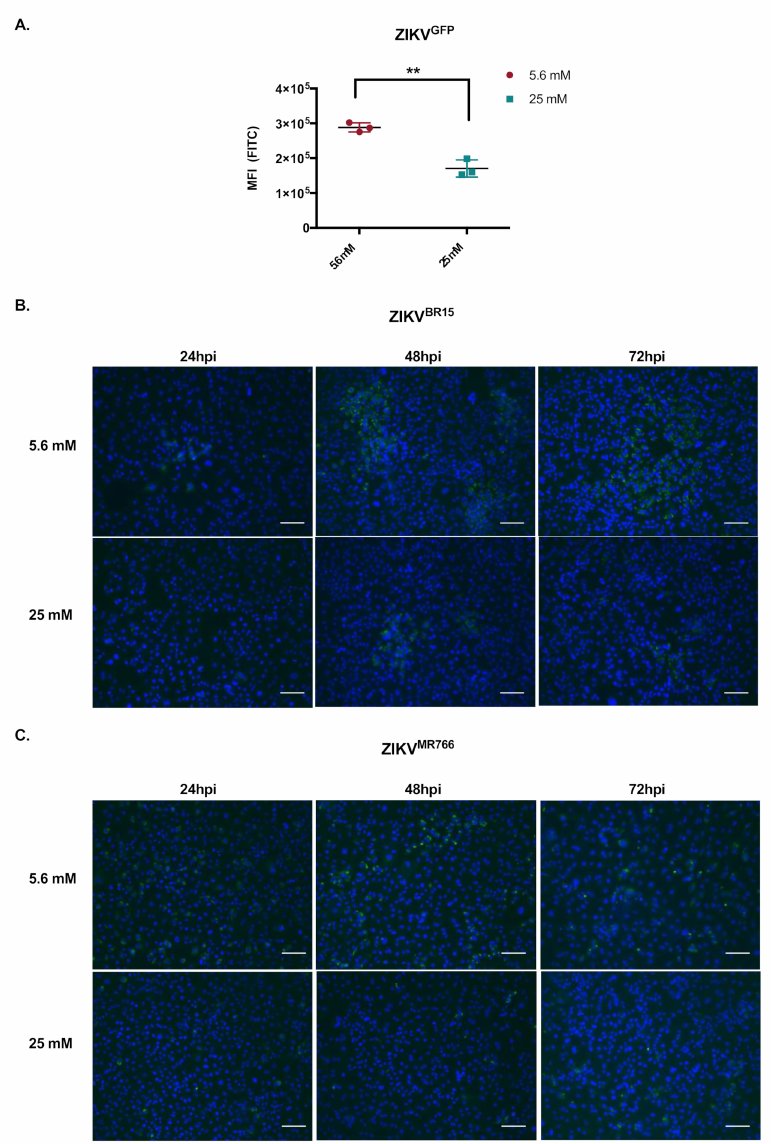
Figure 4. Effect of high glucose on ZIKV replication step. HK-2 cells were infected with ZIKV GFP , ZIKV BR15, and ZIKV MR766 as indicated at an MOI of 1 in low- and high-glucose conditions. ( A ) GFP- expression of ZIKV GFP -infected HK-2 cells were analyzed by flow cytometry at 24 hpi. In ( B , C ) double- stranded RNA (dsRNA) of ZIKV BR15 and ZIKV MR766 was detected by immunofluorescence at 24, 48, and 72 hpi using J2 mAb. ZIKV dsRNA (green) and nuclei (blue) were visualized by fluorescence microscopy. Results are shown as means ± SEM of three independent experiments. Mann-Whitney test shows that the difference between these two conditions are statistically significant (** p < 0.01). Scale bars are 100 µ